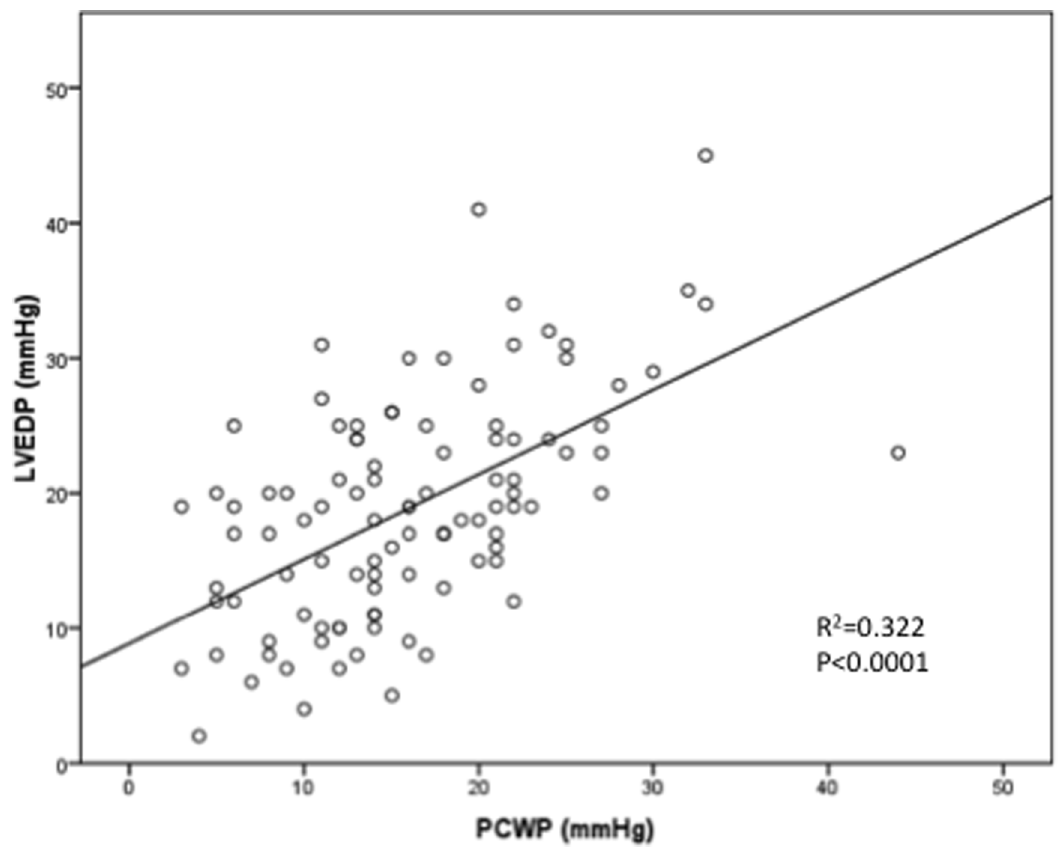
Figure 2. Correlation between PCWP and LEDP in the entire study population. Scatterplot of PCWP and LVEDP pairs for all 101 patients included in the study.